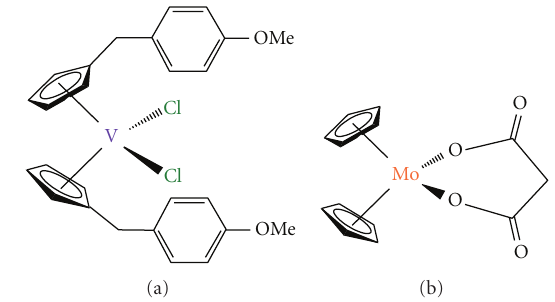
Figure 8: (a) Vanadocene-Y; (b) molybdocene carboxylate deriva- tive.